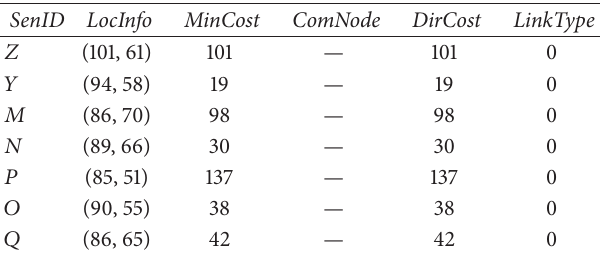
Table 2: Vicinity table (node 𝑋 ) after receiving message from